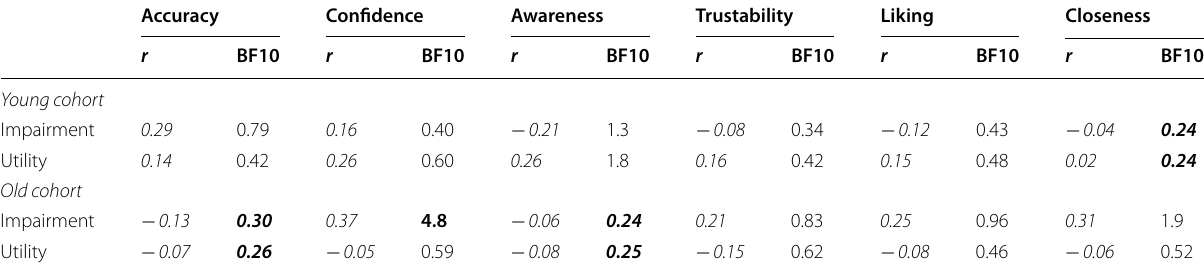
Table 4 Relation between attitudes towards face masks as assessed with the atom questionnaire and face mask effects on emotion recognition and interpersonal